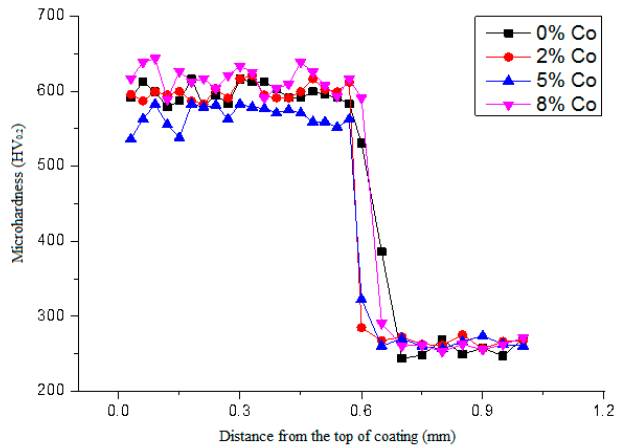
Figure 8. The influence of Co on the microhardness